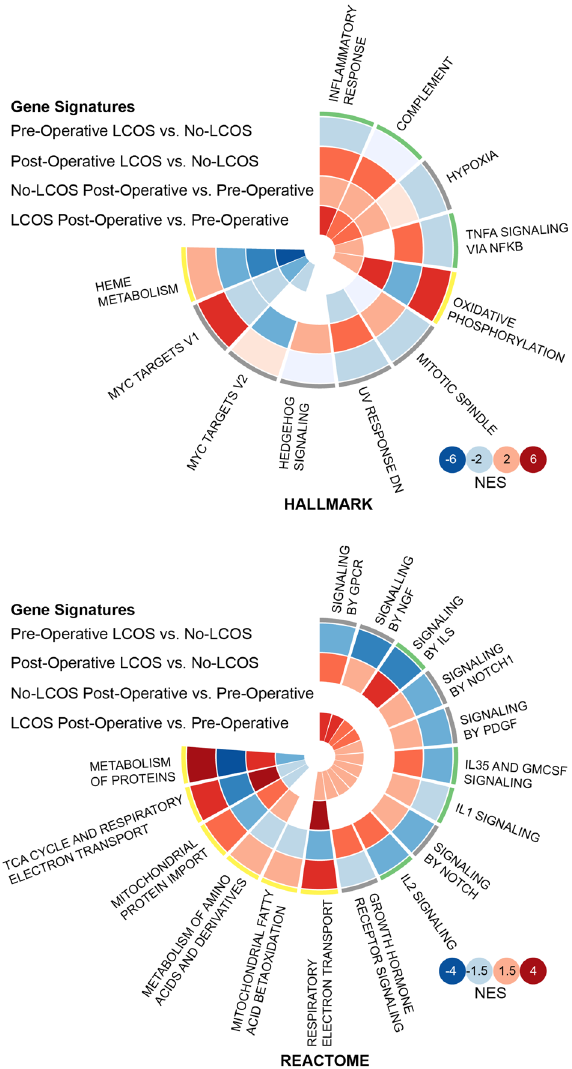
Figure 3. HALLMARK an REACTOME enriched pathways: distribution of Normalized Enrichment Scores (NES) for various pathophysiological pathways. From outside of circle to the inside: outermost circle compares NES scores in Pre-Operative samples of patients who developed LCOS versus No-LCOS, the second circle compares NES scores in Post-Operative samples of patients who developed LCOS vs patients who did not, the third circle compares NES scores between Pre and Post-Operative samples of patients who did not develop LCOS, the innermost circle compares NES scores between Post-Operative and Pre-Operative samples of patients who developed LCOS. (GSEAsoftware version 3.0. https ://softw are.broad insti tute.org/cance r/softw are/ gsea/wiki/index .php/GSEA_v3.0_Relea se_Notes